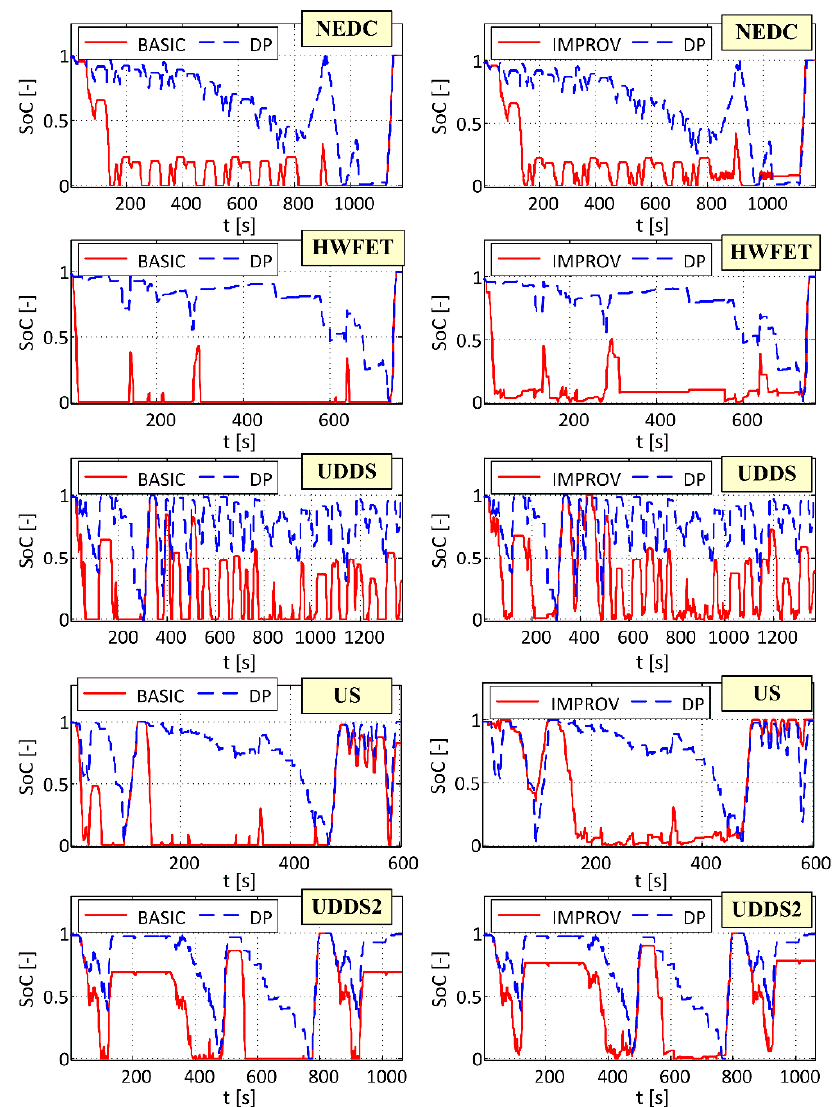
Figure 12. SoC trajectories of BASIC and IMPROV management strategies presented parallel to optimum SoC trajectories obtained by DP optimization for different driving cycles.